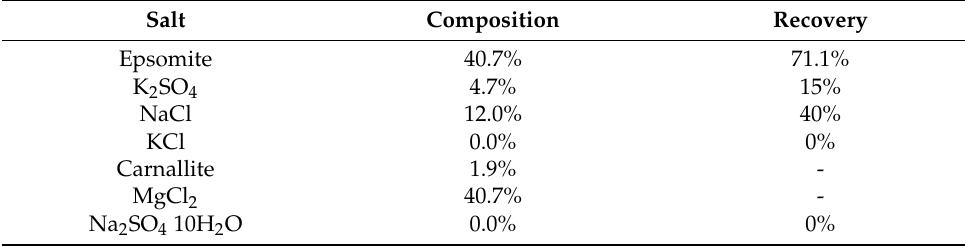
Table 9. Composition of the salts recovered from crystallizer 4.